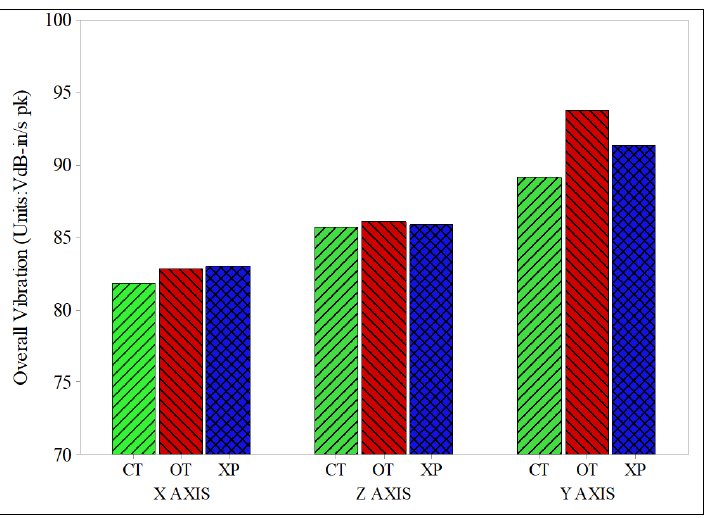
Figure 6. Results of the overall vibration measured in the X-, Z-, and Y-axis directions.